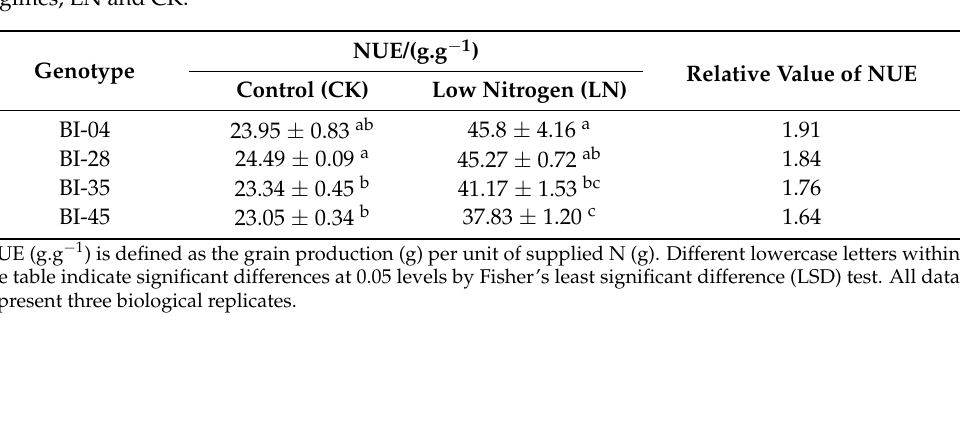
Table 1. The comparison of NUE in four genotypes of barley seedlings grown under two nitrogen regimes, LN and